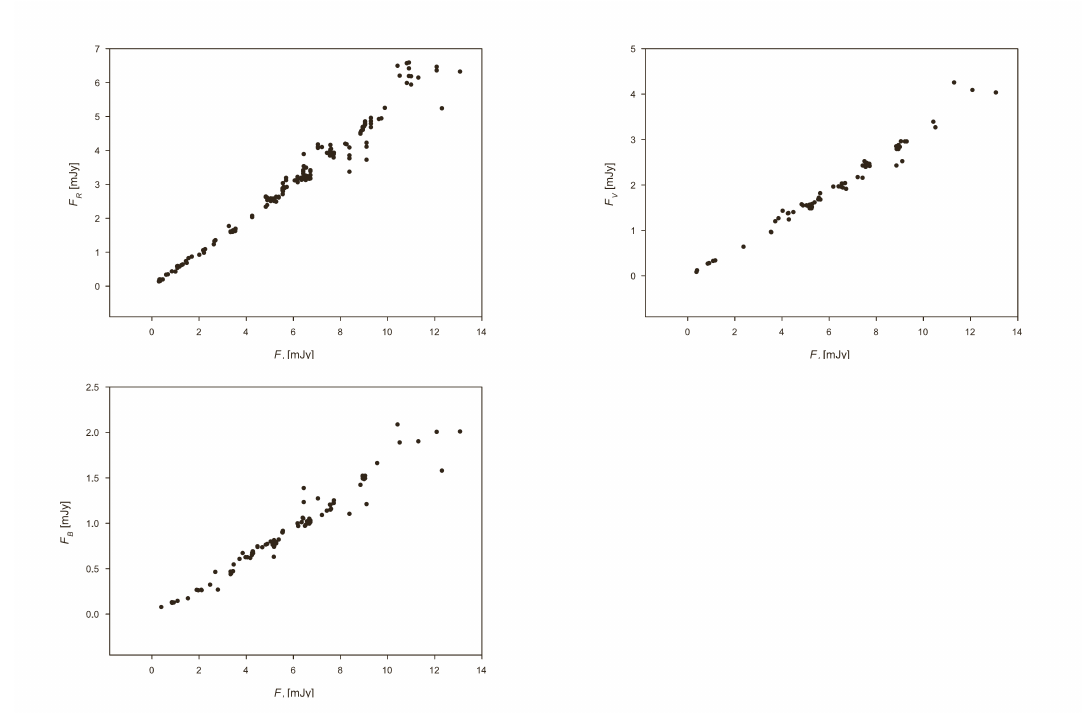
Figure 5. Flux–flux diagrams for outburst